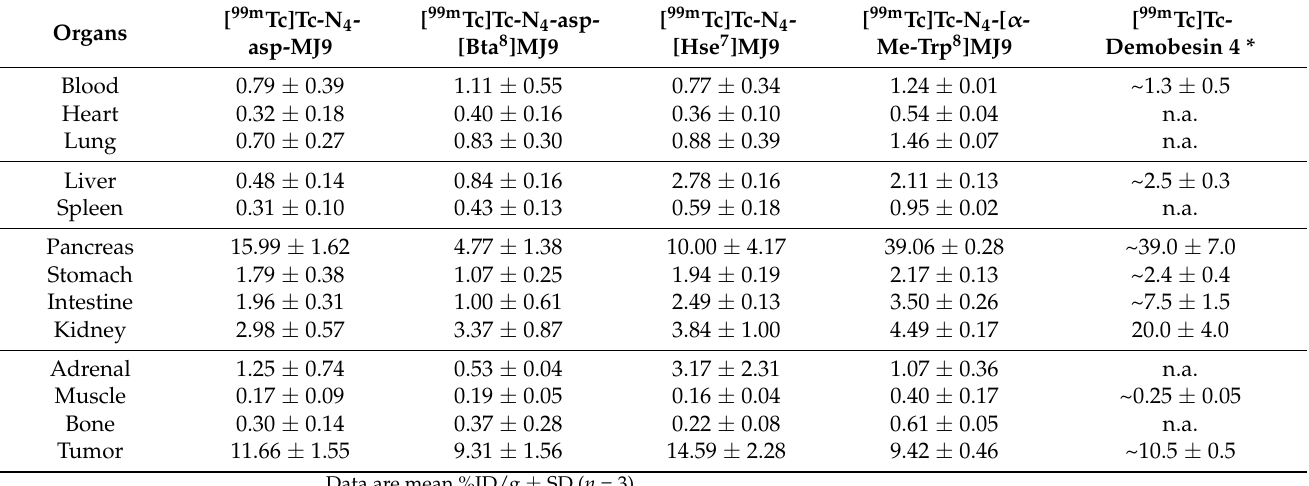
Table 1. Biodistribution data of [ 99m Tc]Tc-N 4 -asp-MJ9, [ 99m Tc]Tc-N 4 -asp-[Bta 8 ]MJ9, [ 99m Tc]Tc-N 4 - [Hse 7 ]MJ9 and [ 99m Tc]Tc-N 4 - [α -Me-Trp 8 ]MJ9 (200 pmol each) compared to [ 99m Tc]Tc-Demobesin 4 at 1 h p.i. in PC-3 tumor-bearing CB17-SCID mice. * 10 pmol, 2 – 3 months old female Swiss nu/nu mice, data determined by Nock et al . [32].